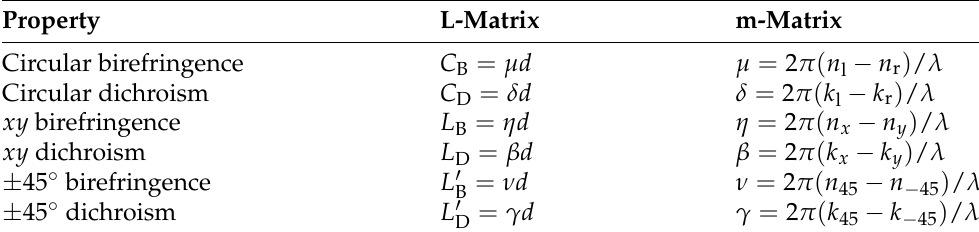
Table 1. Definitions of the fundamental optical properties in the L - and m